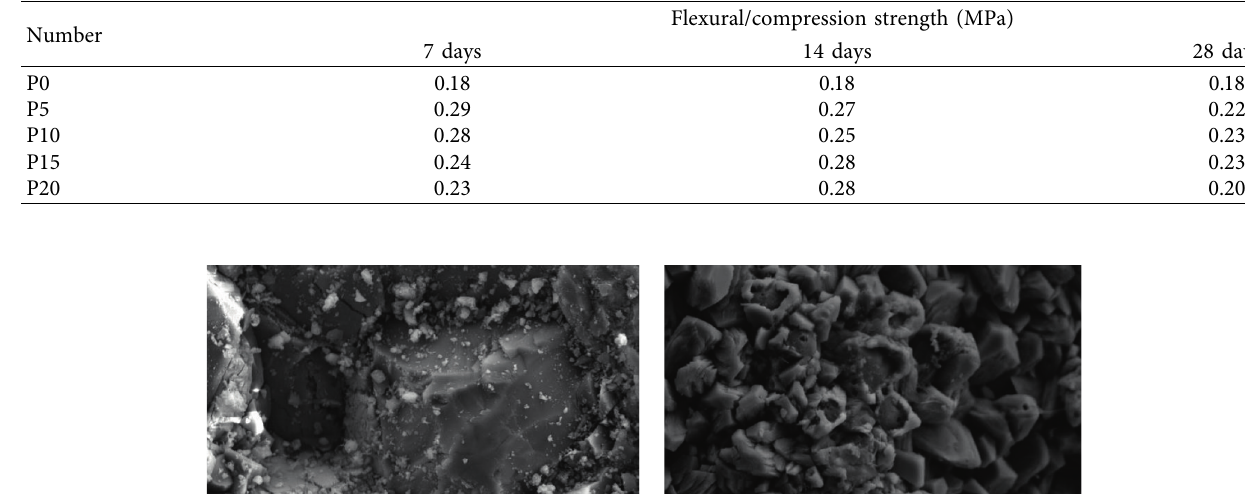
Table 3: Flexural/compression strength ratio of